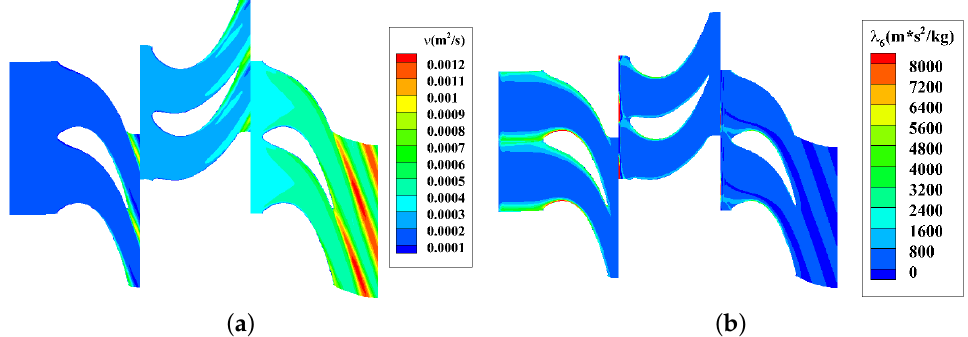
Figure 23. Flow and adjoint fields at 50% span of the Aachen turbine. ( a ) Turbulence quantity. ( b ) Adjoint quantity corresponding to the turbulence model equation.